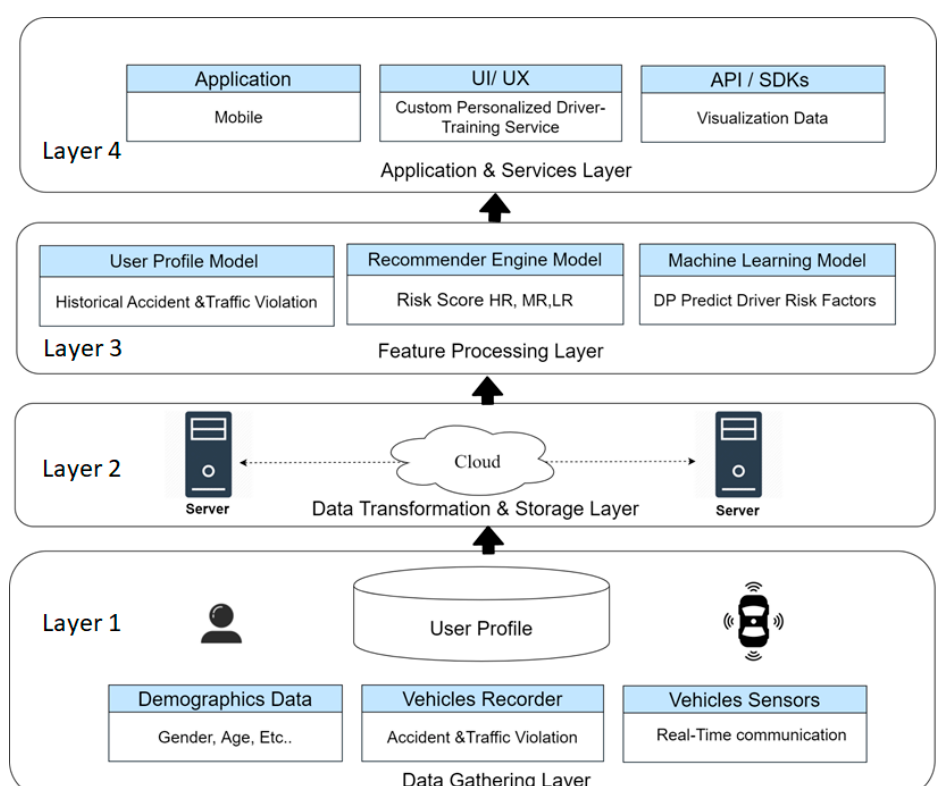
Figure 4. DDP—dynamic driver profile features.